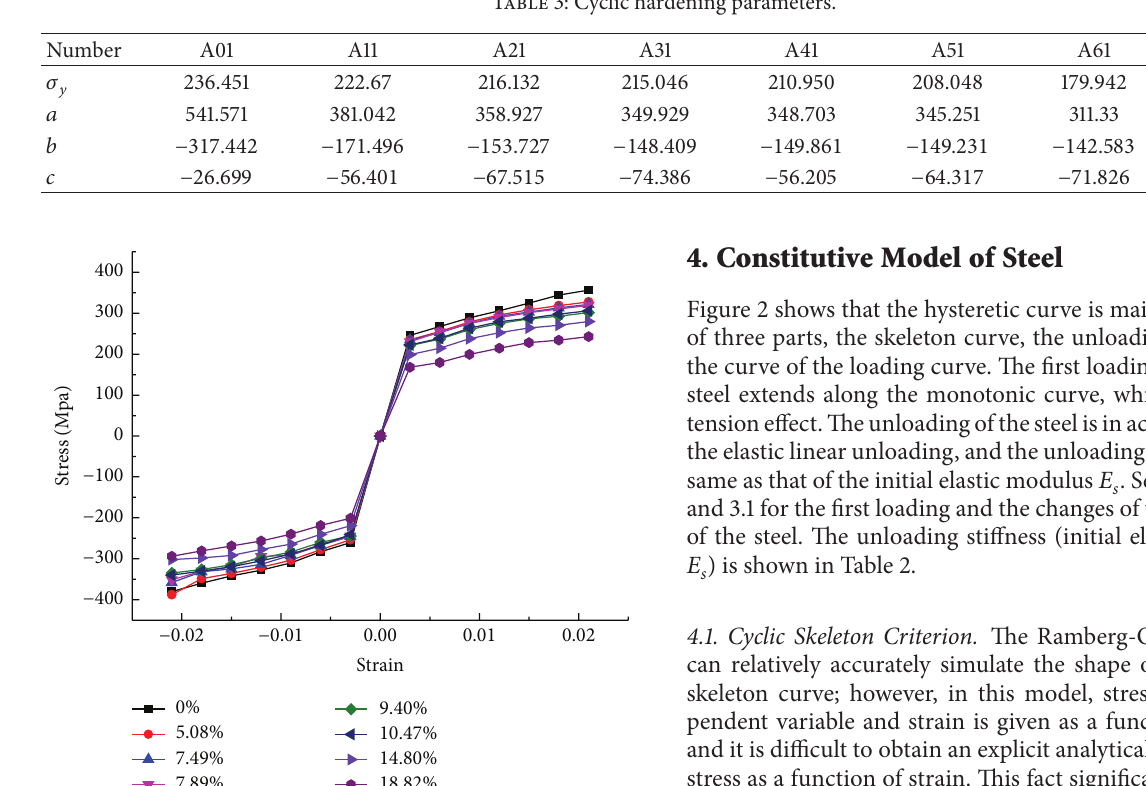
Table 3: Cyclic hardening parameters.